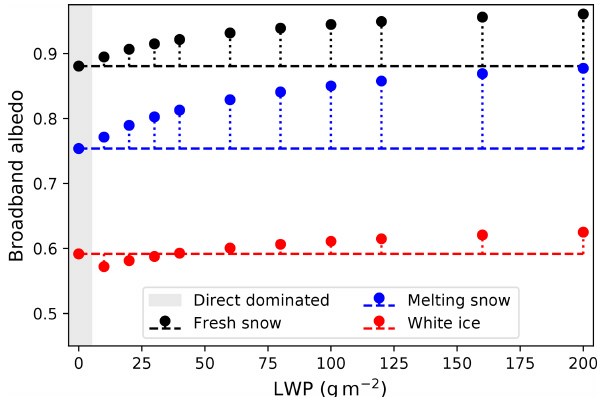
Figure 4. Broadband albedo integrated from simulated upward and downward spectral irradiance as a function of cloud LWP ( r eff of 8µm) using the color-related albedo spectra of Fig. 3 and a SZA of 65 ◦ . The approximate area of direct-dominated radiation is indi- cated by the gray shading. The horizontal dashed line indicates the cloud-free albedo as a